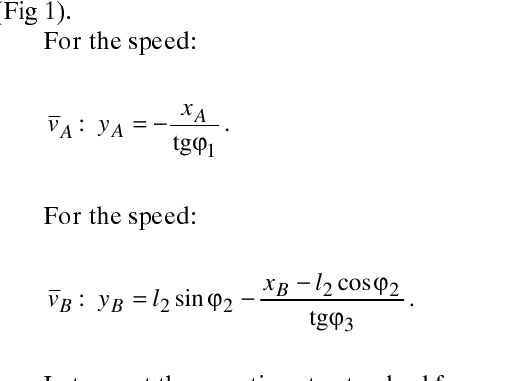
Fig 1. Four-bar l